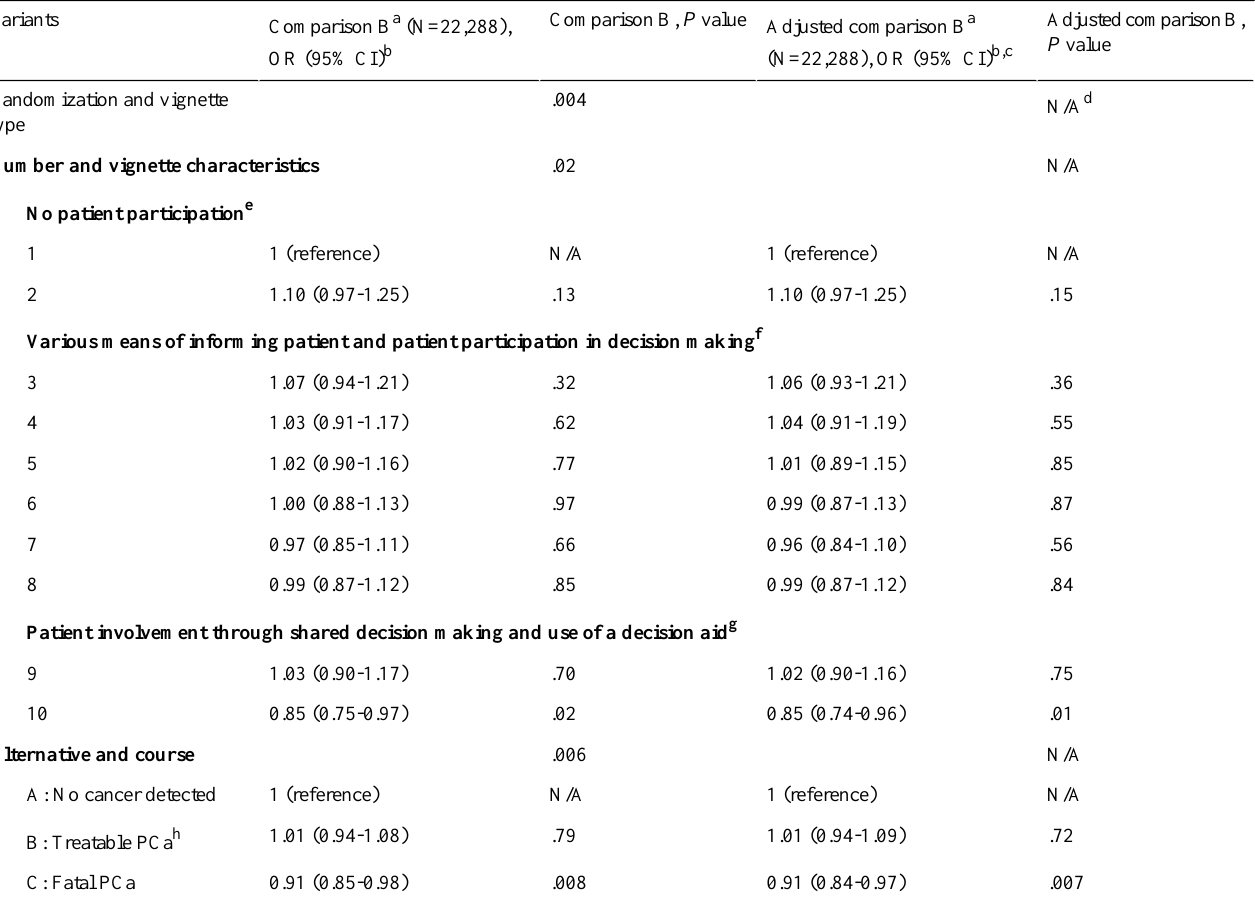
Table 4. Comparison of responders and nonresponders regarding questionnaire